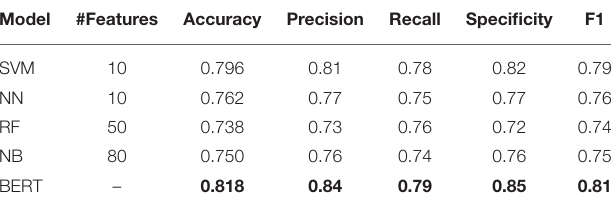
TABLE 7 | Ten-fold CV results averaged across three runs with different random seeds on the ADReSS train set. Model